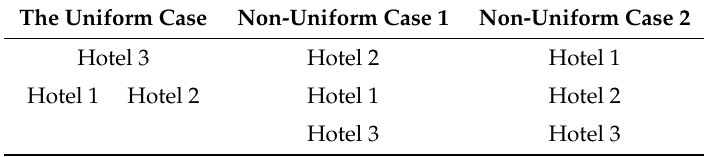
Table 5. Results obtained in the three